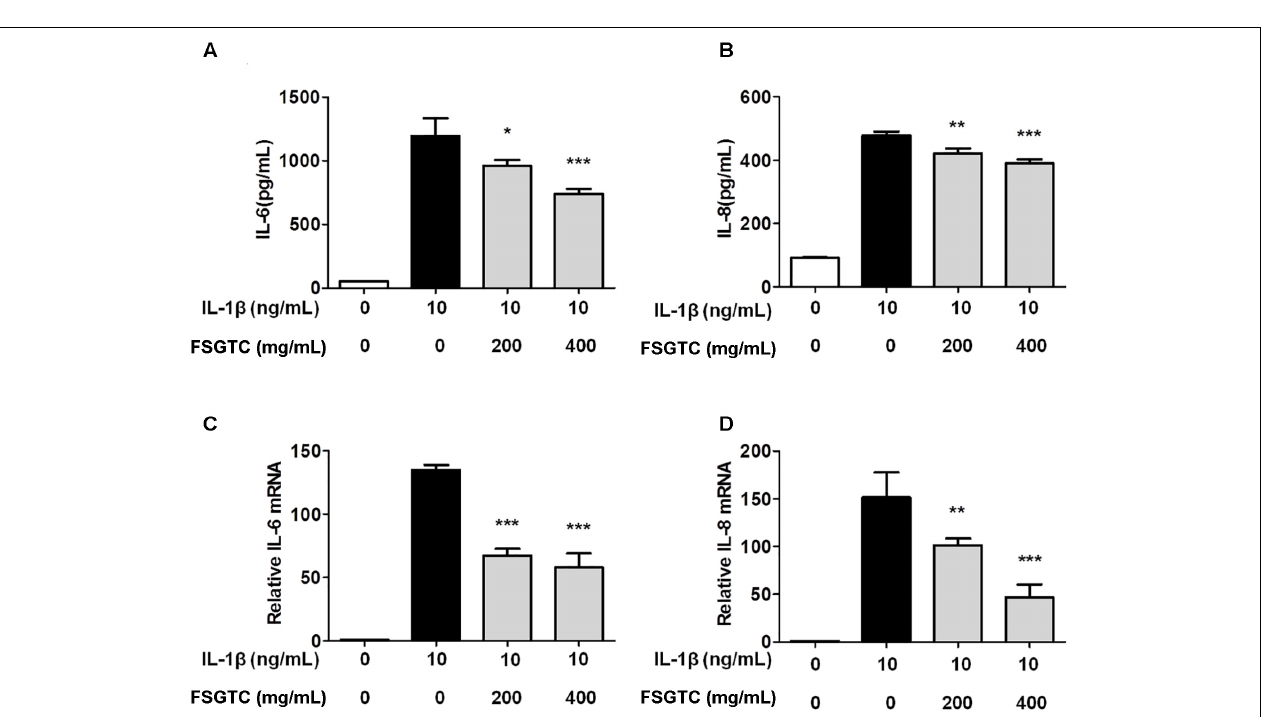
FIGURE 3 | Effects of FSGTC on serum levels of TNF- α (A) and IL-6 (B) . Rats were orally treated with various doses (200 and 400 mg/kg) of FSGTC. Subsequently, serum was sampled, separated, and concentration determined using ELISA kits. Data are represented as mean ± SD. Statistical analyses were performed by one-way ANOVA test, followed by Dunnett’s post hoc test. n = 8, x ± s . ∗ p < 0.05, ∗∗ p < 0.01, ∗∗∗ p < 0.001 vs. IL-1 β without FSGTC.